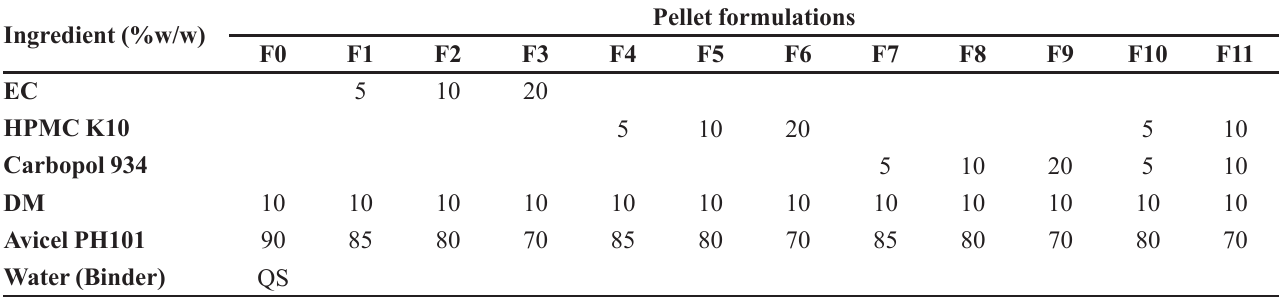
TABLE I - Composition of various DM pellet formulations Ingredient